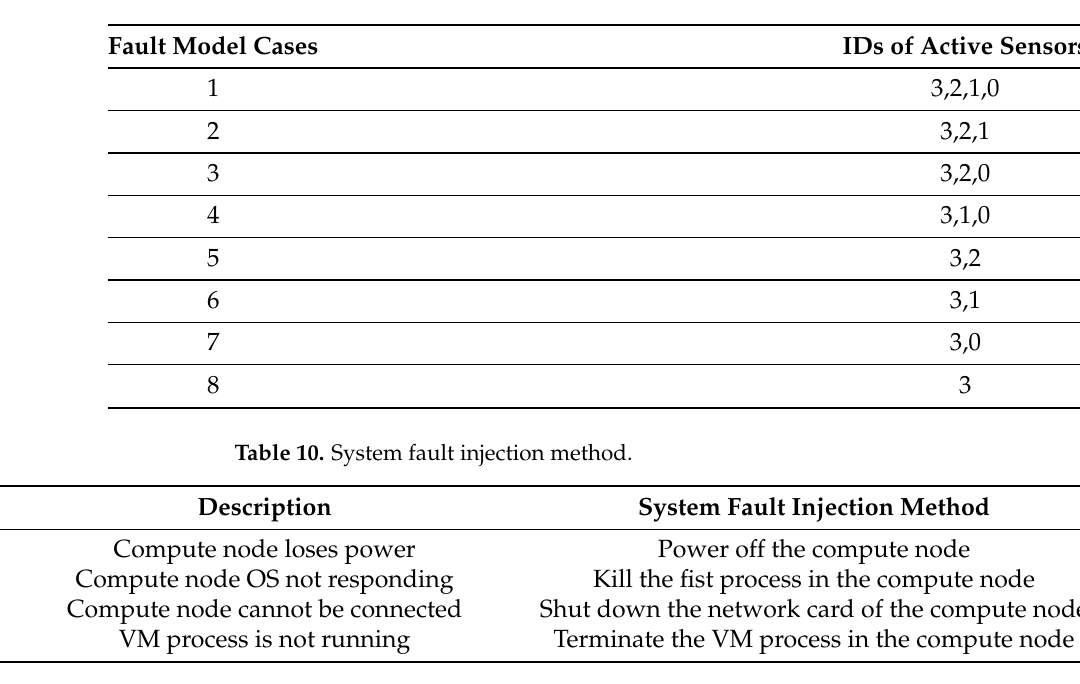
Table 9. Fault models with the IDs of active sensors.